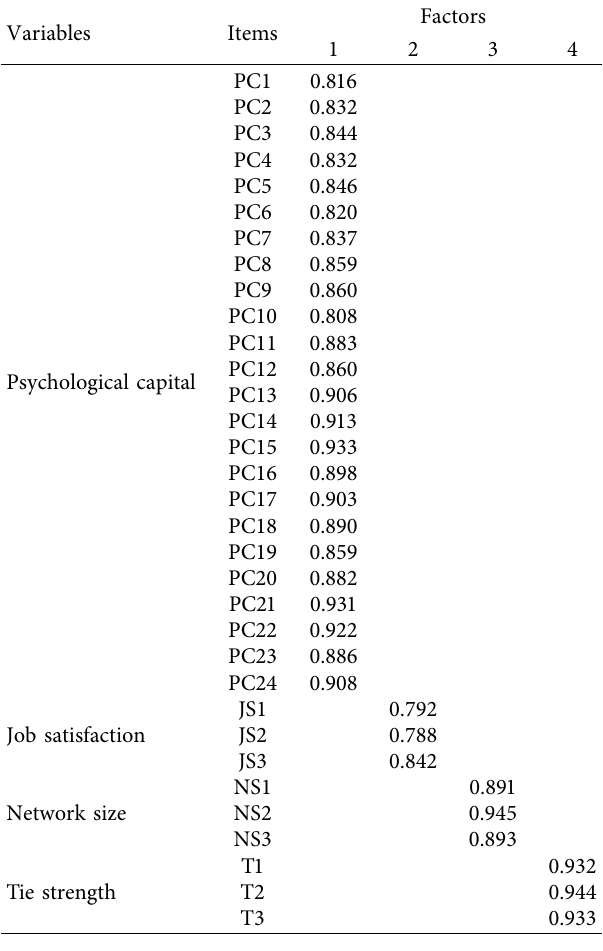
Table 7: Hierarchical regression of moderating effect of